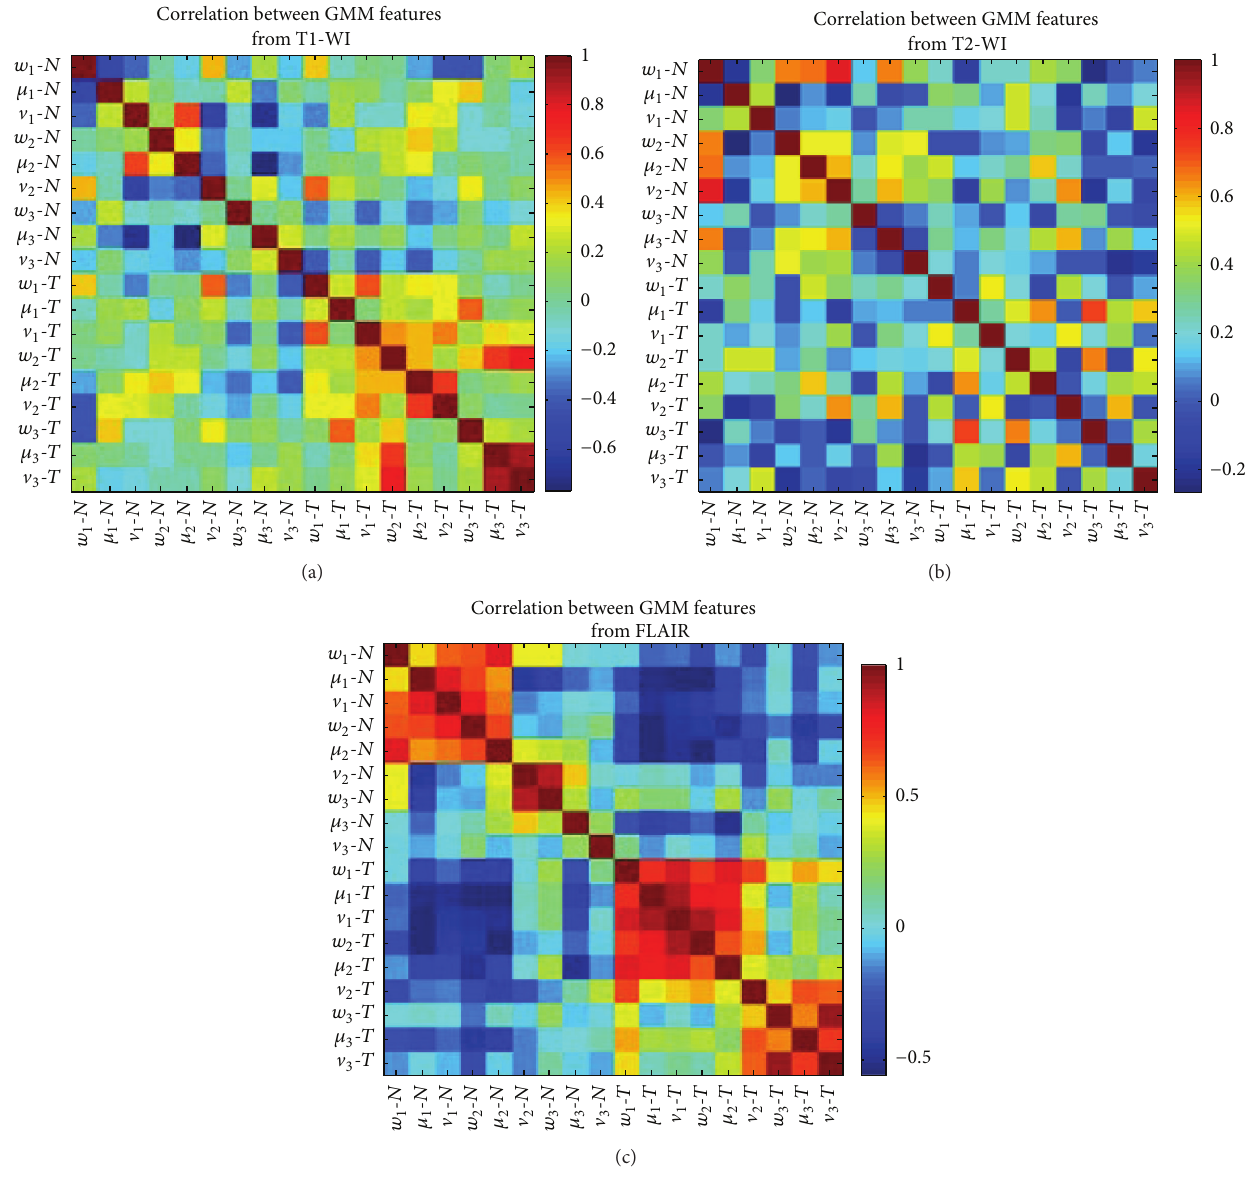
Figure 6: Heat map with correlation coefficients between GMM features: 𝑤 , 𝜇 , and V are the weight, average, and variance, respectively; 𝑁 and 𝑇 are the index of normal and tumor (GBM) areas,